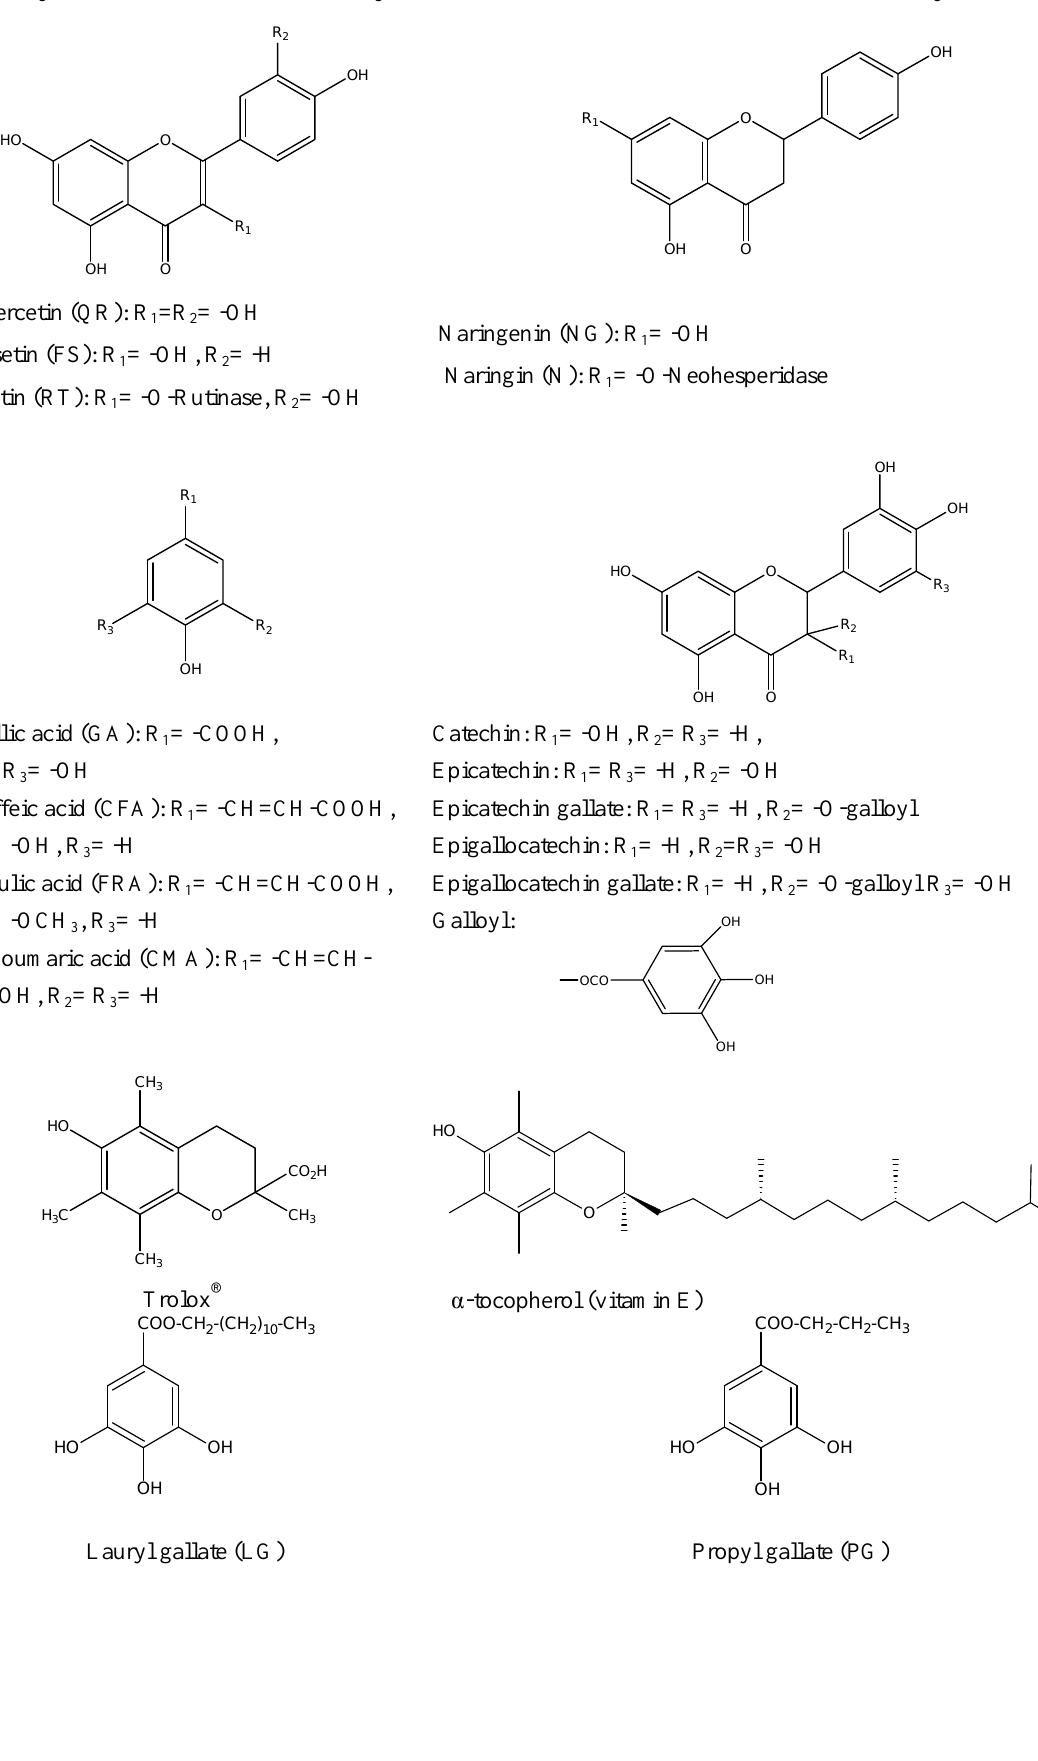
Figure 5. The formulas of the hydrophilic and lipophilic antioxidants (and of methyl- β - cyclodextrin used in solubility enhancement) tested with the CUPRAC